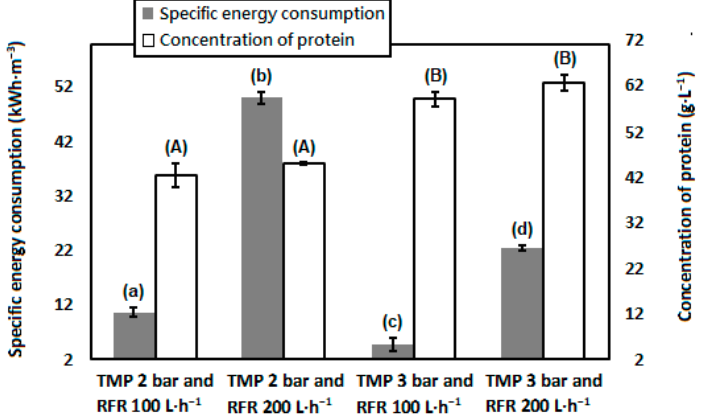
Figure 3. Specific energy consumption and concentration of protein in the retentate side of membrane for different trans-membrane pressures (TMPs) and retention flow rates (RFRs) in static turbulence promoter-implemented filtration process. Results are represented by mean value with standard deviation (± values). In superscript, dissimilar alphabet represents the significant difference between results, evaluated by the Tukey’s post hoc method.